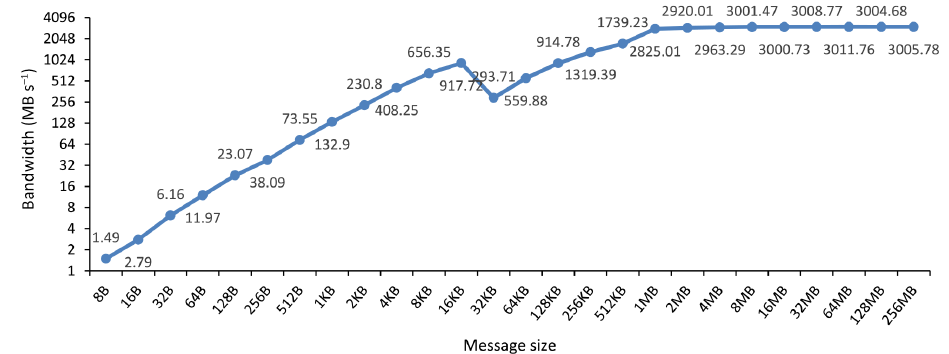
Figure 2. Variation of bandwidth ( y axis) of an MPI P2P communication with respect to the message size ( x axis). The results are generated from our benchmark. In the benchmark, one process sends messages with different sizes to the other process. The two processes of the P2P communication run on two different computing nodes of